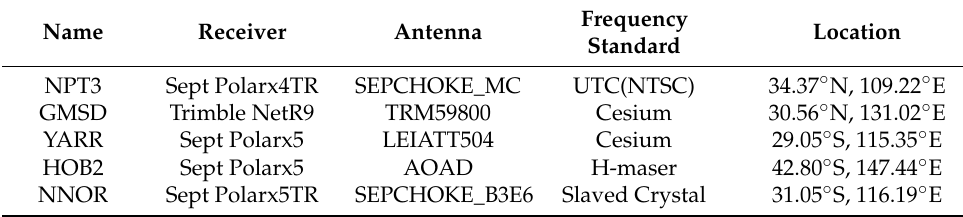
Table 3. Detailed information about the five stations.